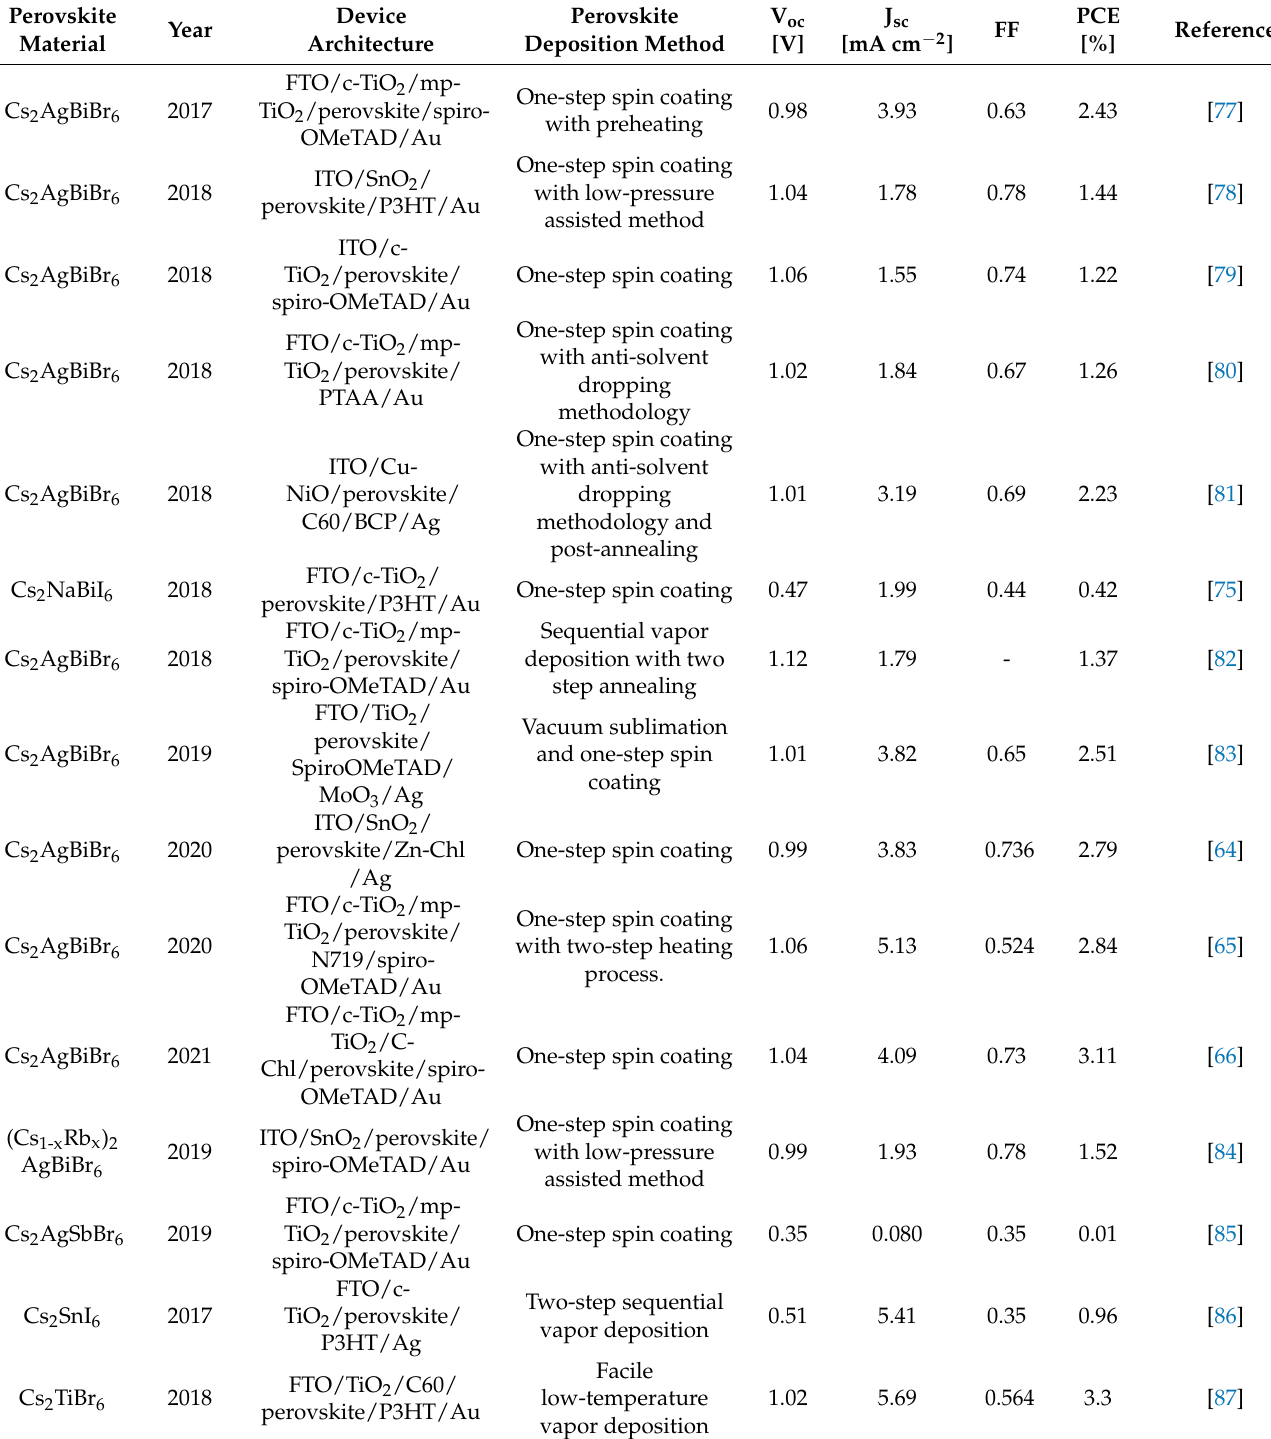
Table 2. Prepared device architecture and photovoltaic parameters of Cs-based double halide perovskite solar cells. Perovskite